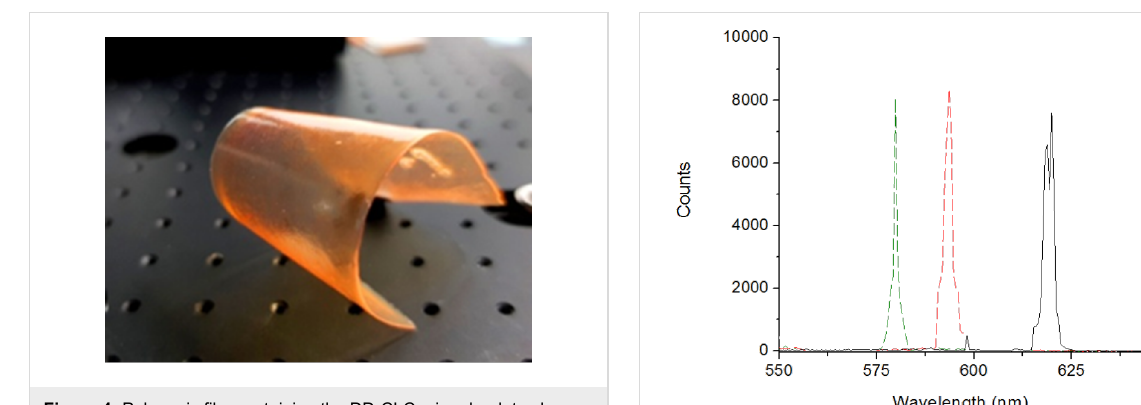
Figure 4: Polymeric film containing the DD-CLC microdroplets ob- tained after water evaporation.